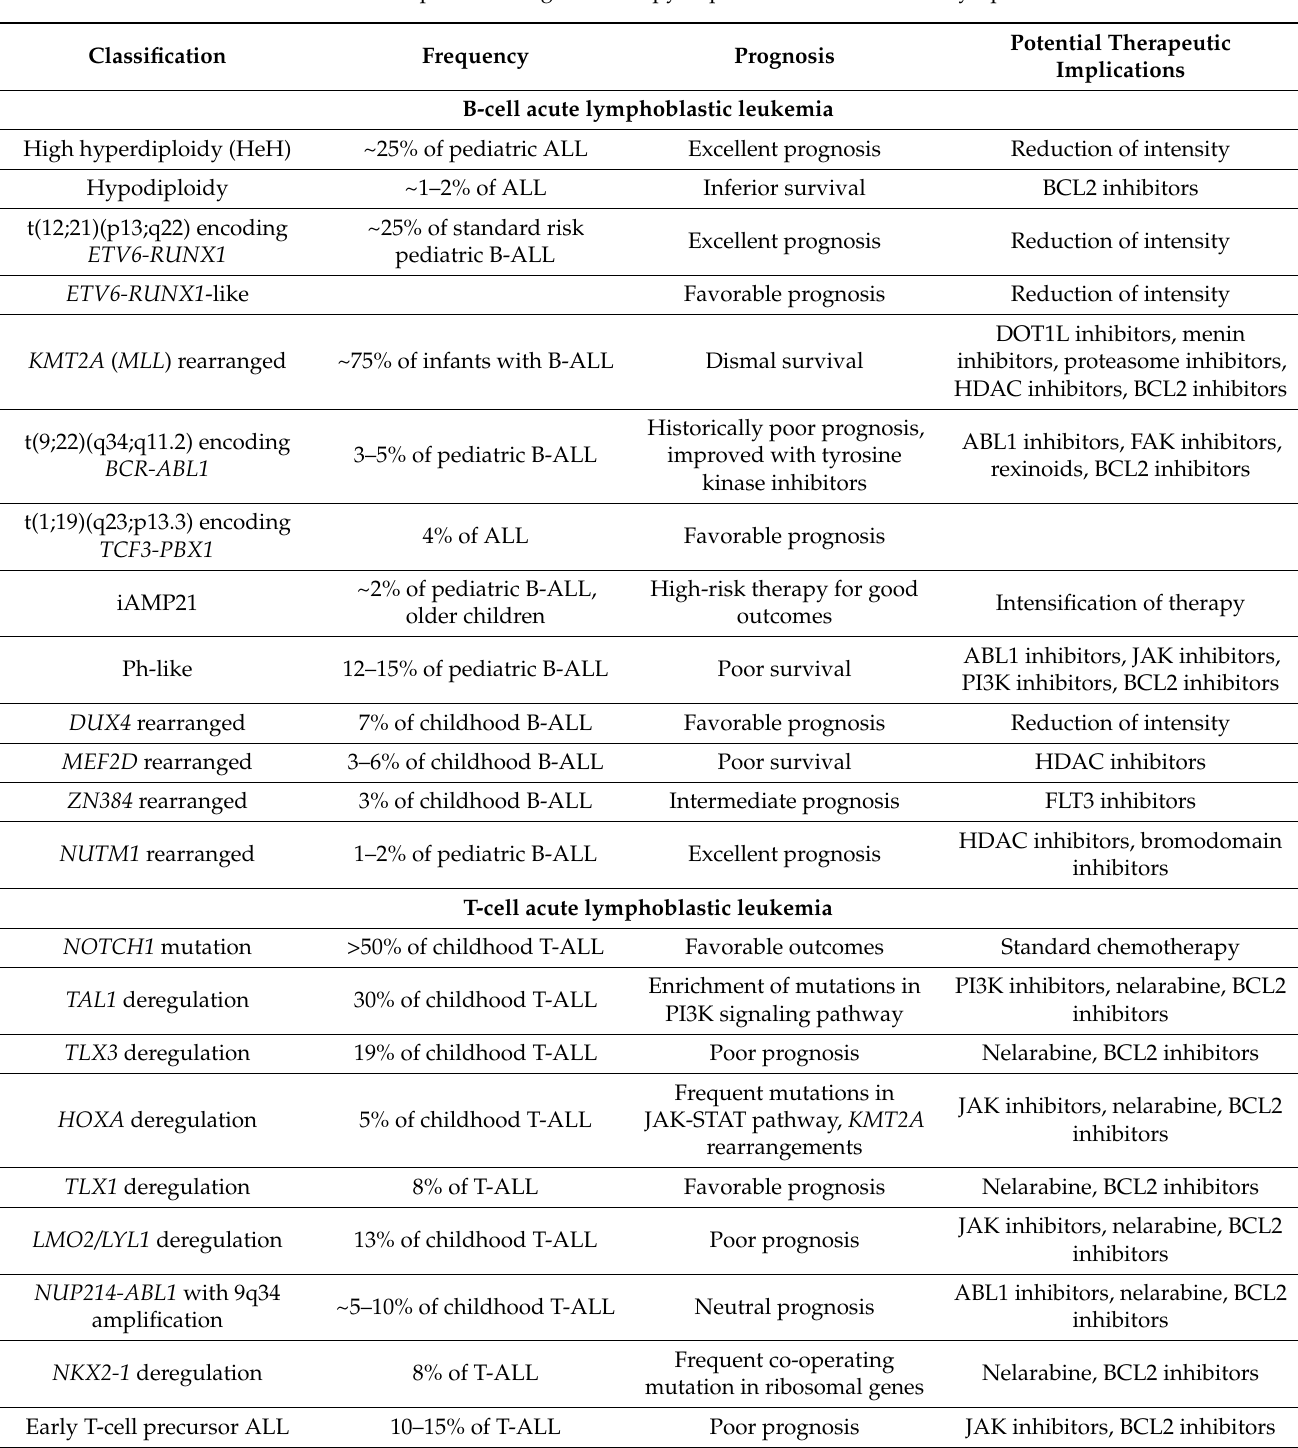
Table 1. Genetic alterations and potential targeted therapy in pediatric B- and T-acute lymphoblastic